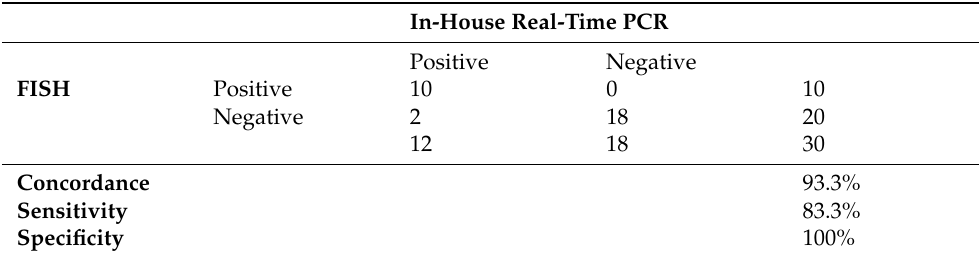
Figure 2. FISH staining results in respiratory secretions with sputum and BAL (bronchoalveolar lavage) samples. Magnification 1000×. No size band available, so the 5–8 µm size of the Pneumocystis cysts serves as a size standard. ( a ) Positive sputum sample, stained with the probe JP1 targeting P. jirovecii , visualized in green. ( b ) Positive BAL sample, stained with the probe JP1 targeting P. jirovecii , visualized in green. ( c ) Negative sputum sample. Of note, Grocott’s staining was not applied with respiratory samples in this study and only cysts were seen. Table 2. Comparison of in-house real-time PCR results and FISH staining results with respiratory secretion. Real-time PCR was used as the reference